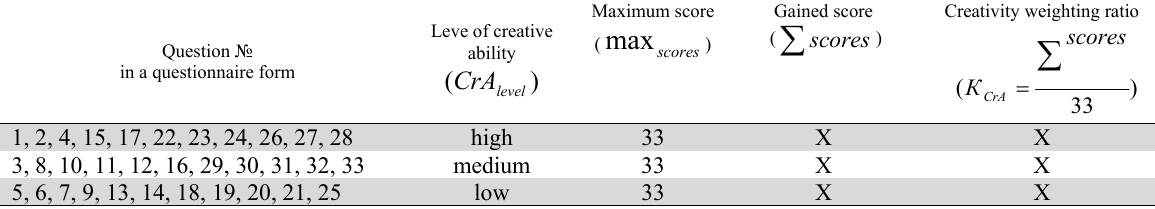
The interpretation of survey scores for a personal CrA